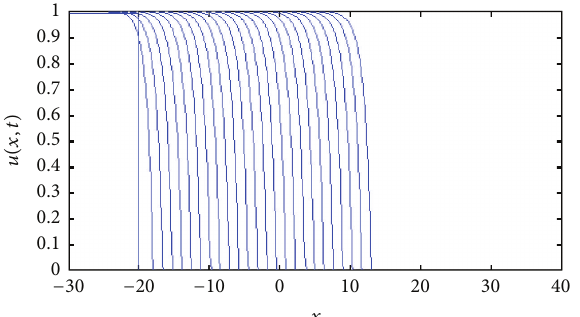
Figure 19: Evolution of a compact support function as initial con- dition under the reaction-diffusion convection process described by (39). The numerics show that as the time grows, the approximative solution tends to the sharp traveling wave solution. Profiles are for ℎ 󸀠 (𝑢) = 𝑢 + 𝑘𝑢 2 at equal time intervals 𝑡 = 1,2,3, .. . with 𝑔(𝑢) = 𝑢(1 − 𝑢) and 𝐷(𝑢) = 𝑢(1.0 + 𝛽𝑢) for 𝛽 = 1 .